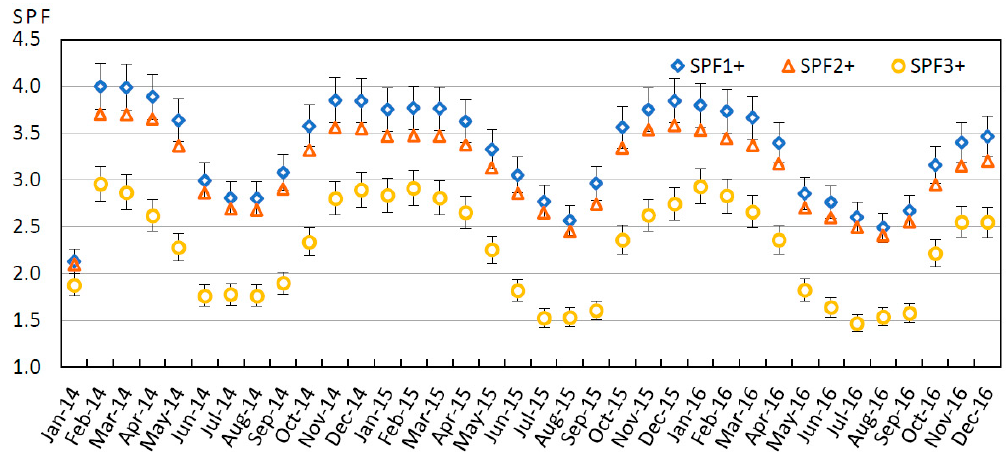
Figure 22. Monthly SPF 1 + , SPF 2 + , and SPF 3 + values based on Annex 52 Figure 22. Monthly SPF 1+ , SPF 2+ , and SPF 3+ values based on Annex 52 boundaries. Figure 22. Monthly SPF 1+ , SPF 2+ , and SPF 3+ values based on Annex 52 boundaries. Figure 22. Monthly SPF 1+ , SPF 2+ , and SPF 3+ values based on Annex 52 boundaries.